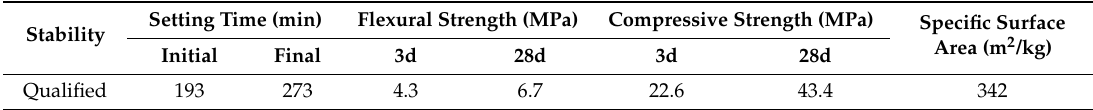
Table 2. Technical specifications of cement.